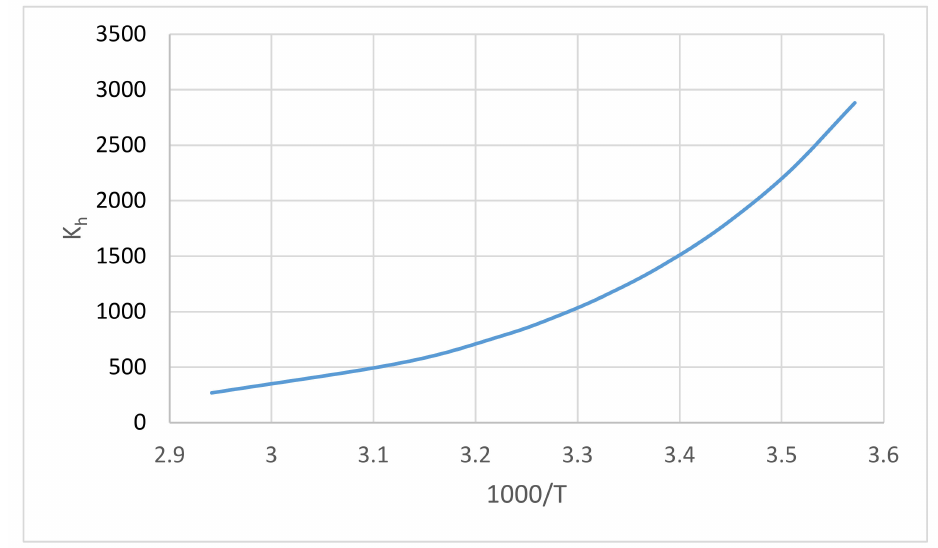
Figure 3. Diagram of the formaldehyde hydration chemical equilibrium constant Equation